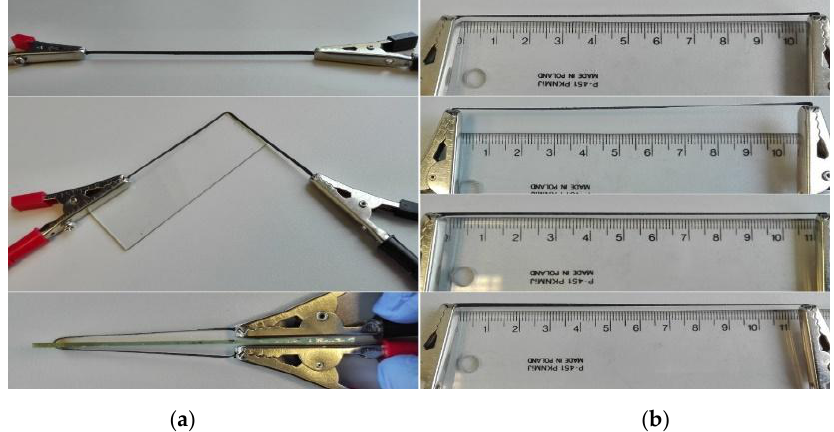
Figure 6. Procedures employed for flexibility testing of RTV/GNP composite testing: ( a ) – bending, angle, from top to bottom: 0°, 90°, 180°; ( b ) – stretching, elongation, from top to bottom: 0%, 4.5%, 9%, 13.5% (glass and ruler are shown for scale only).